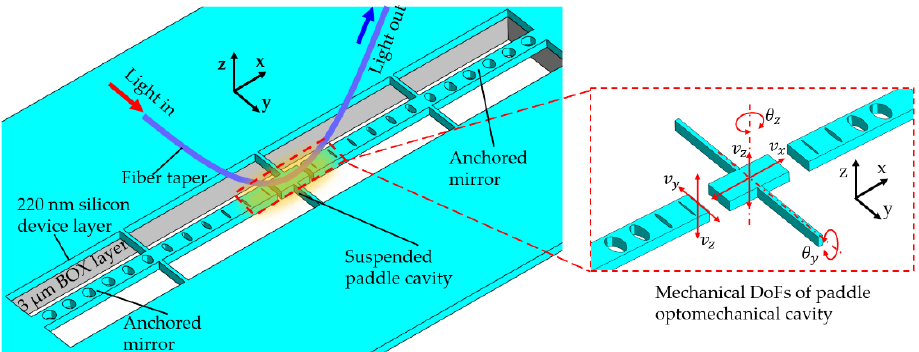
Figure 16. Schematics of photonic crystal paddle nanocavity (inset: mechanical modes of paddle cavity) [117–119] .